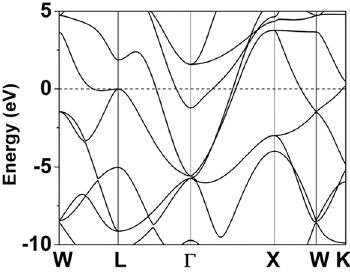
Fig. 1 Calculated electronic band structure for LaH 10 at 300 GPa [5]